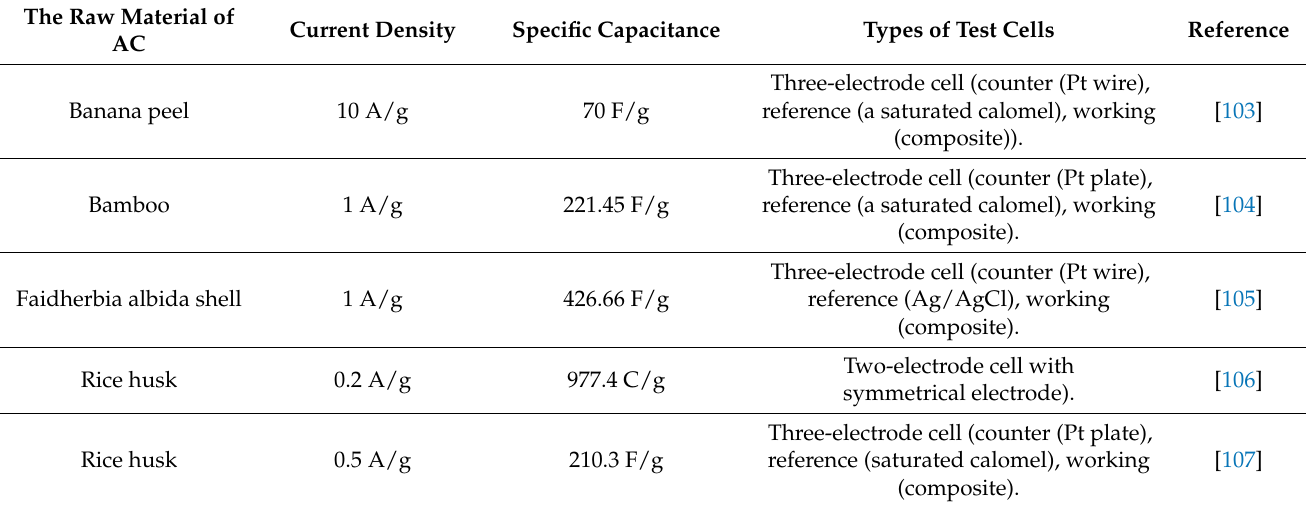
Table 5. Biowaste-derived AC and MnO 2 composite-based electrodes for the